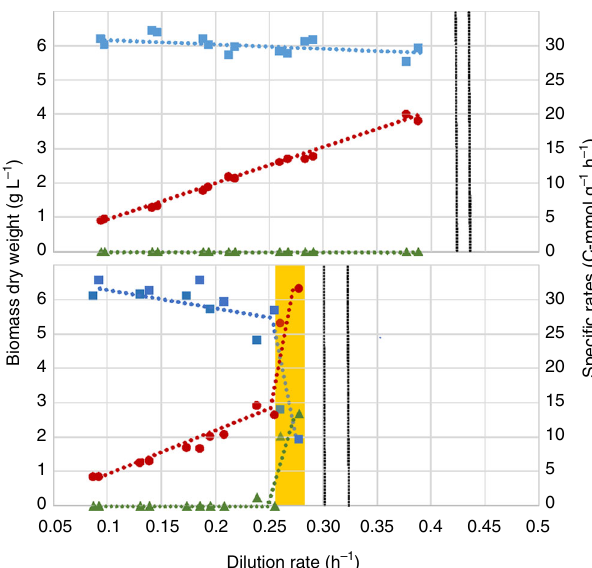
Fig. 3 The long-term Crabtree effect is triggered by overexpression of CRA1 . The control strain exhibited a fully respiratory metabolism and was washed out after D max = 0.4 h − 1 (upper panel). The metabolic activity of the CRA1 overexpression strain, however, shifted from respiratory metabolism to respiro-fermentative metabolism and started to produce ethanol when D crit = 0.27 h − 1 was achieved (lower panel). Above D crit glucose consumption rates increased sharply while biomass concentrations dropped. Mean values of biomass dry weight concentration (squares), speci fi c glucose consumption (circles) and speci fi c ethanol production rates (triangles) of the control and CRA1 overexpression strain at different dilution rates during the chemostats are given (chemostats were performed in duplicates). Gray and black lines show the dilution rates of the biological replicates at which the cells were washed